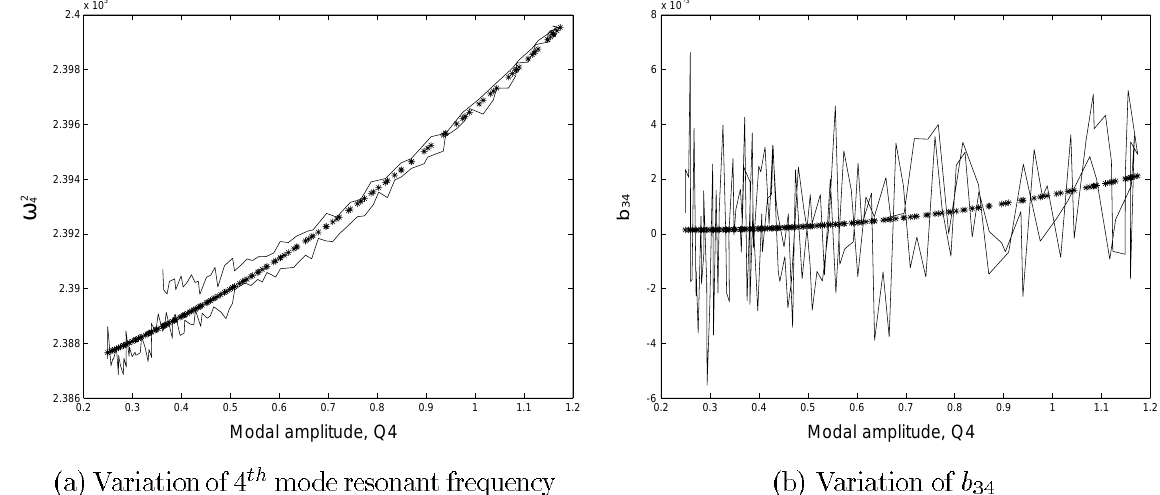
Fig. 8. Noise effect on non-linear modal parameter extraction: Extracted values, − − − Fitted values.